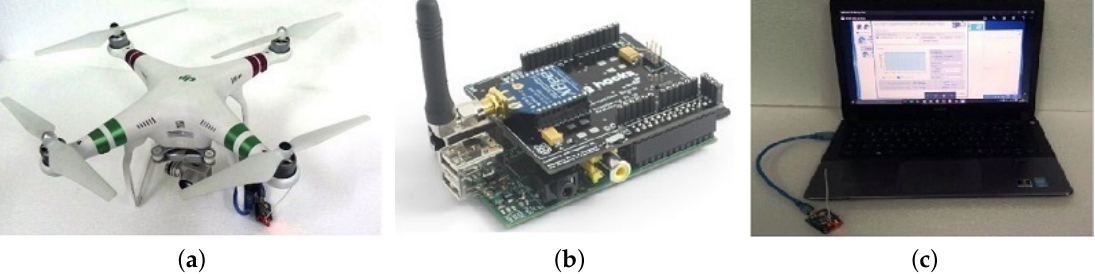
Figure 7. Hardware specification of the proposed multi-UAV system. ( a ) XBee module embedded in UAV Phantom 3 Standard; ( b ) XBee module connected to the power bank; ( c ) BS equipped with a XBee